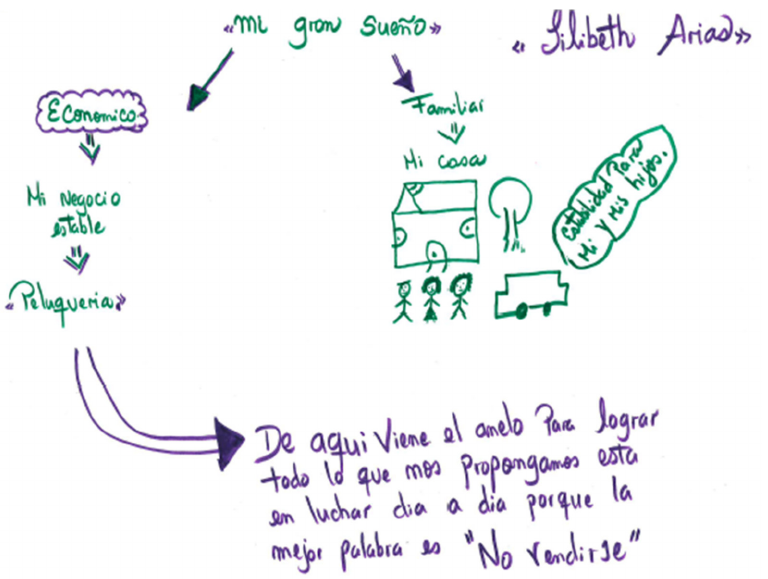
Figure 2. Mental map drawn by a female research participant in Cúcuta (Colombia) detailing her dreams for her business and her family. Translation: “My big dream”. Economical: My stable business. Family: My house as stability for my children and me. This is my yearning. To achieve all we set out to achieve, we must fight day by day. The best words are “Don’t give